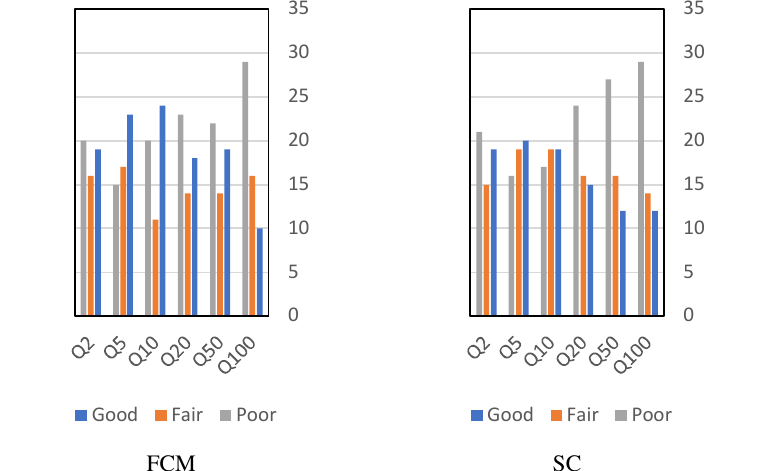
Figure 6. Grouping REr (%) values for FCM, SC, and GP.